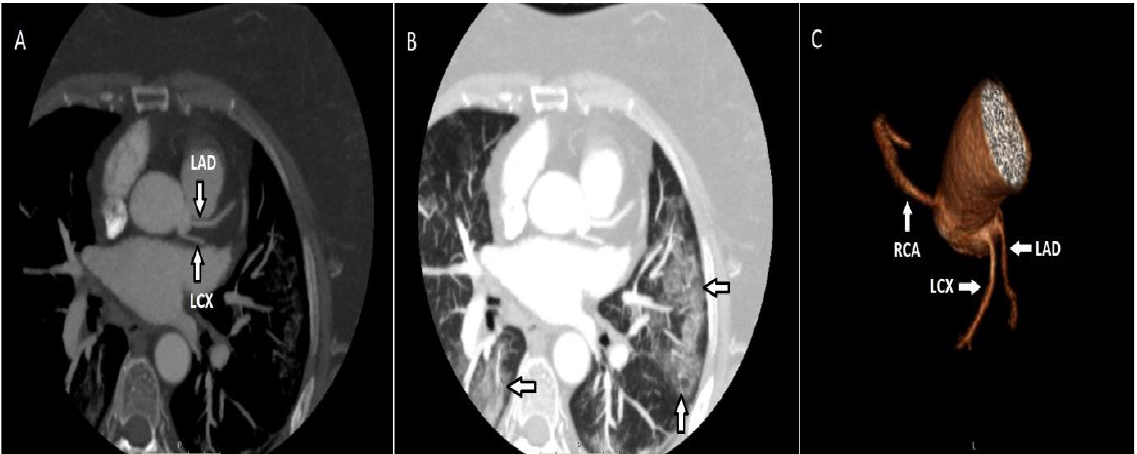
Figure 1. Maximum-intensity projection (MIP) of the axial CT image ( A ) demonstrates the LCX and LAD emerging from the left coronary sinus with separate ostia. The same patient had ground glass infiltrates consistent with COVID-19 ( B ). On the volume-rendered (VR) image ( C ), the LAD and LCX emerge from the left coronary sinus, along with the RCA emerging from the right coronary sinus.